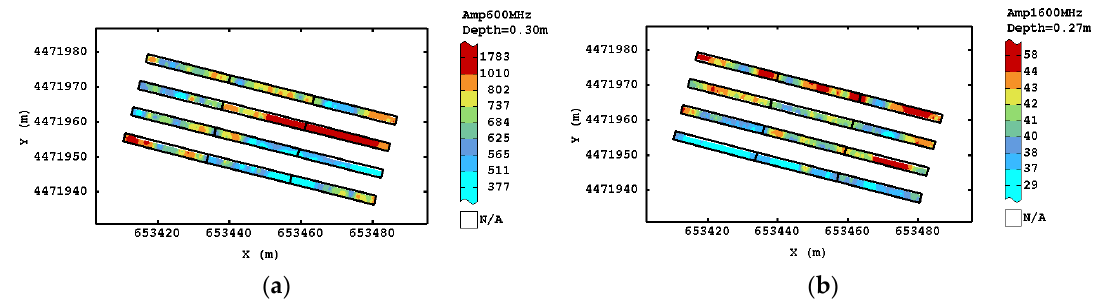
Figure 9. Estimated amplitude maps for the 600 MHz antenna at ( a ) 0.30 m and amplitude maps for the 1600 MHz antenna at ( b ) 0.27m.